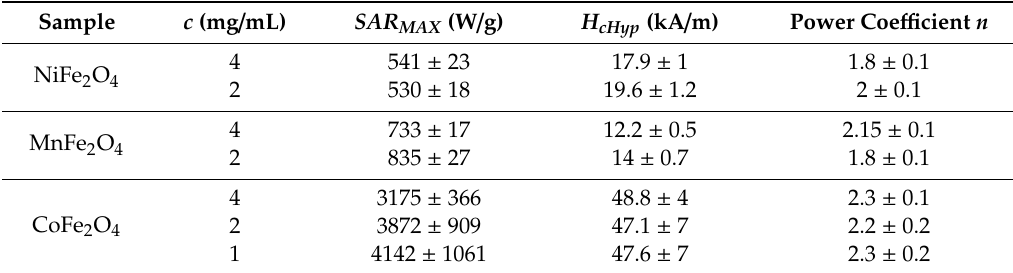
Table 3. Fitting results of SAR evolution with AMF